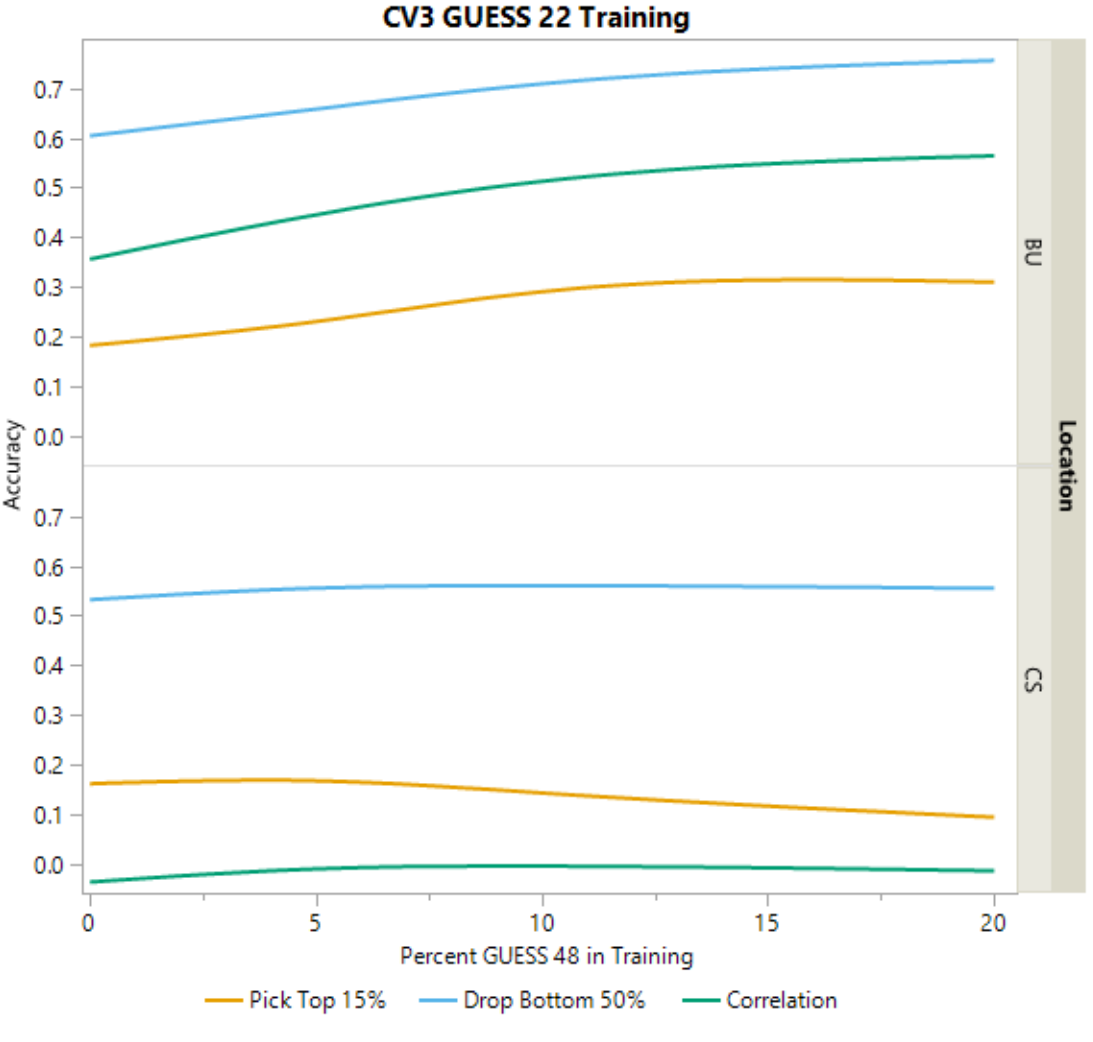
Figure 5. Prediction accuracies for CV3 in Bushland (BU) and College Station (CS). Accuracies for grain yield are presented with varying levels of GUESS 48 being added to the training data that include all of GUESS 22. Accuracy for grain yield was assessed in three ways, the proportion of hybrids correctly predicted in the top 15%, the proportion of hybrids correctly predicted in the bottom 50%, and correlation between predicted and actual values.